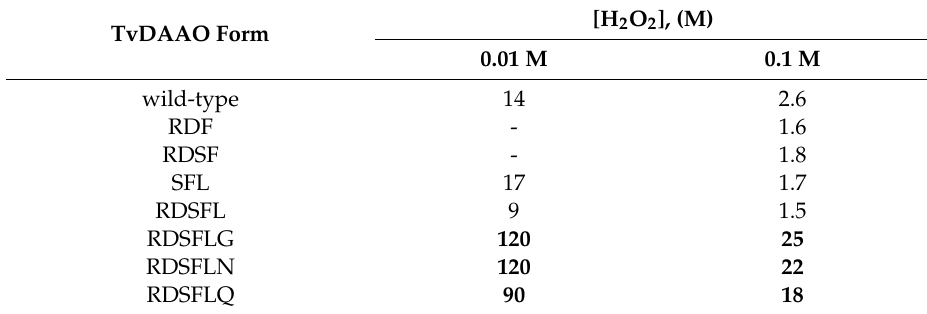
Figure 3. Inactivation time-course for TvDAAO mutants and wild-type enzyme in 0.1 M H 2 O 2 (0.1 M potassium phosphate buffer pH 8.0, 30 °C). Enzyme concentration is 10 µg/mL. Table 3. Half-life times τ 1 / 2 (min) of TvDAAO mutants and wild-type enzyme under hydrogen peroxide inactivation (0.1 M potassium phosphate buffer pH 8.0).